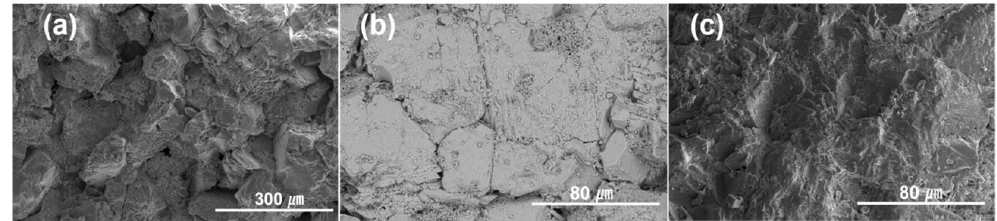
Figure 8. Surface morphology of the stone samples. ( a ) is a blank stone sample, ( b ) is an aragonite-treated sample, and ( c ) is a vaterite-treated sample.